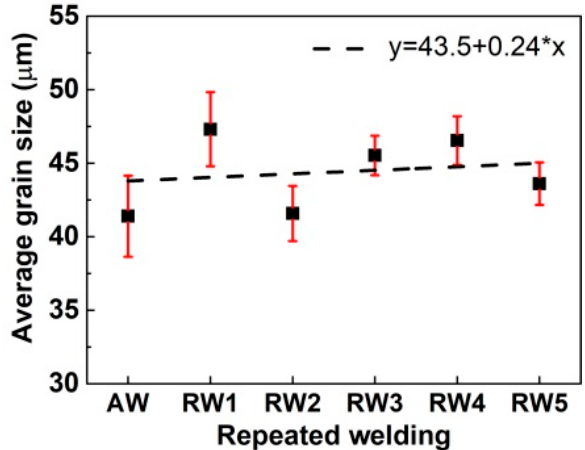
Figure 11. Average grain size of the AW and RW1–RW5 specimens by metallography.